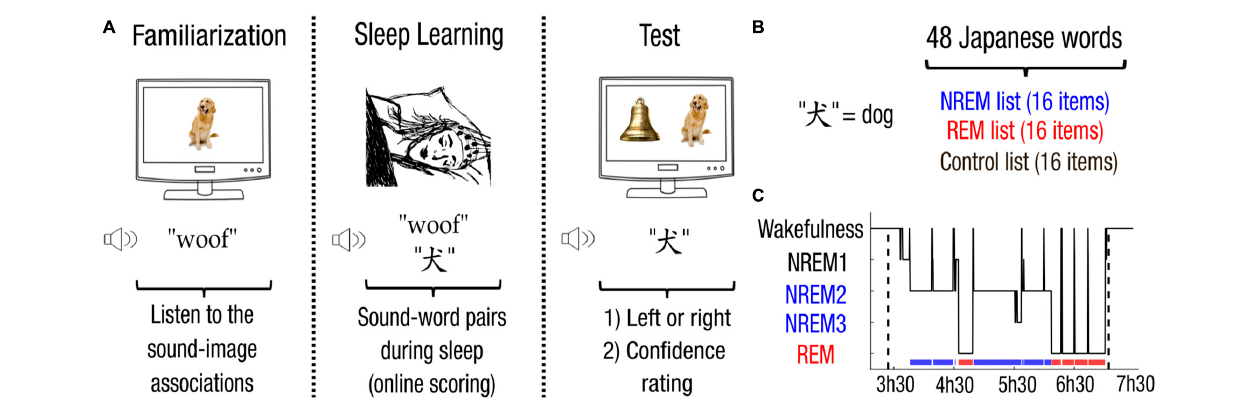
FIGURE 1 | Associative Transfer Learning paradigm. (A) During the first phase performed awake, participants were familiarized with the 48 sound-image pairs. Participants were then allowed to fall asleep. Whenever participants entered NREM or REM sleep, sounds from the corresponding list were played simultaneously with their corresponding Japanese translations. Upon awakening, participants performed a memory test. Japanese words were played with two images belonging to the same list (i.e., NREM, REM, or control list). Participants first chose which image correctly depicts the Japanese word (left or right), and then provided their confidence on a three-level scale (null, low, high). (B) For each participant, the 48 Japanese words (e.g., the Japanese equivalent for “dog”) were randomly assigned into 3 lists, resulting in a NREM, a REM and a control list of 16 items each. (C) Sleep scoring (hypnogram) of the experiment for one